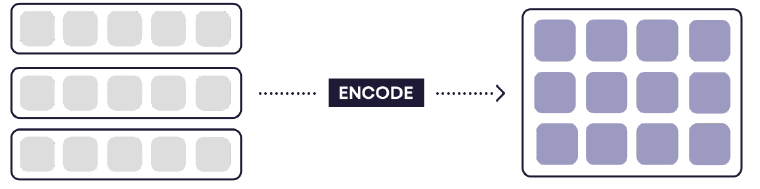
Figure 4. Encode process.